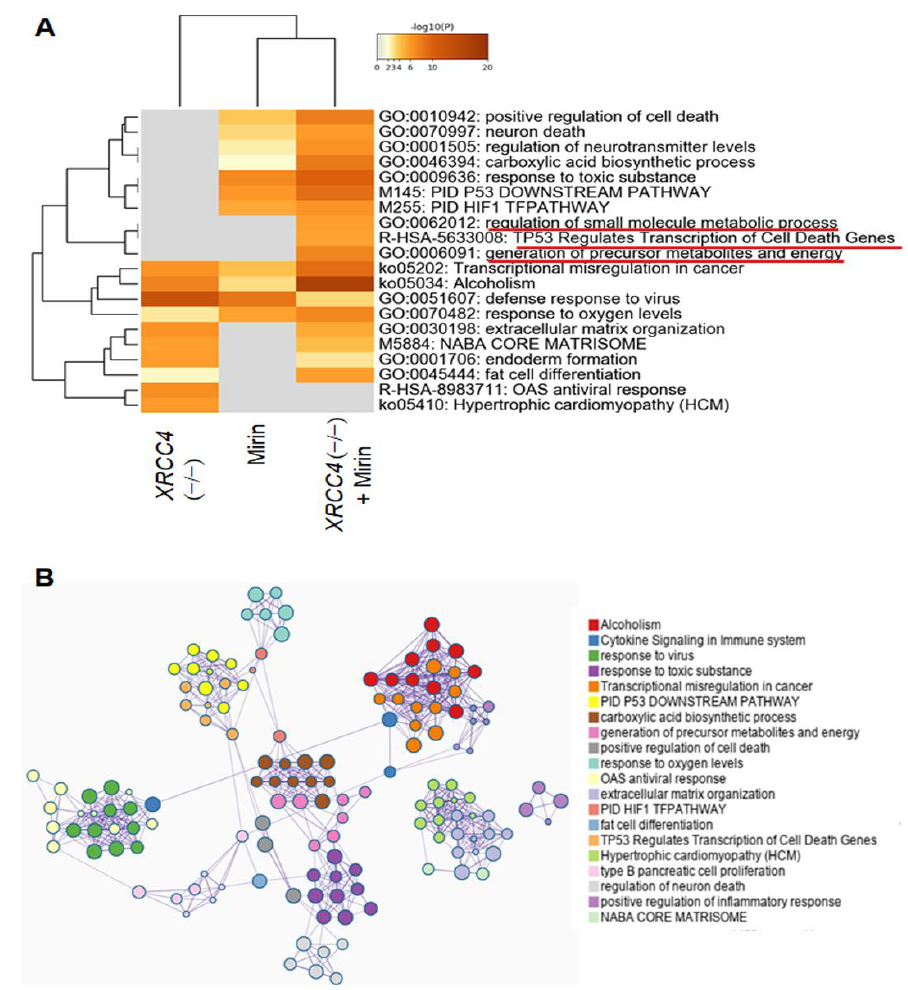
Figure 6. Functional enrichment analysis. ( A ) A heatmap with embedded dendrogram showing relationships between enriched GO/KEGG terms and canonical pathways. 0.3 kappa score was applied as the threshold to cast the tree into term clusters. Differential expression is calculated from samples compared to control HeLa-NT cells. Key pathways with large changes in gene expression for the XRCC4 knockout +mirin sample are underlined with red lines. ( B ) A network graph with enrichment ontology clusters colored by cluster ID. Each term is represented by a node, where its size is proportional to the number of genes for each term. Terms with a similarity score >0.3 are linked by an edge (the thickness of the edge represents the similarity score). The network was created with Cytoscape (v3.1.2). The analyses are based on duplicate